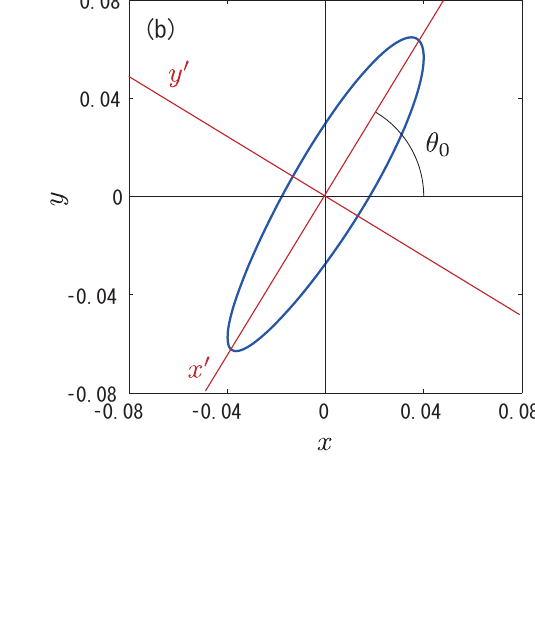
and the new coordinate system ( x (cid:48) , y (cid:48) ) ( b 0